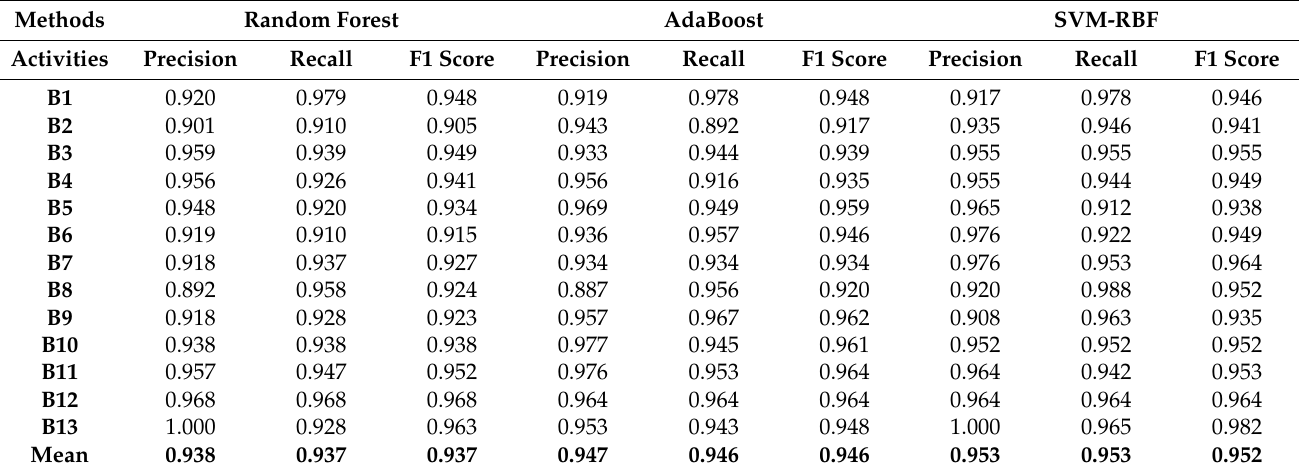
Table 6. Comparison of the evaluation metrics (precision, recall, and F1 score) of the HPAR model from the MobiAct dataset.